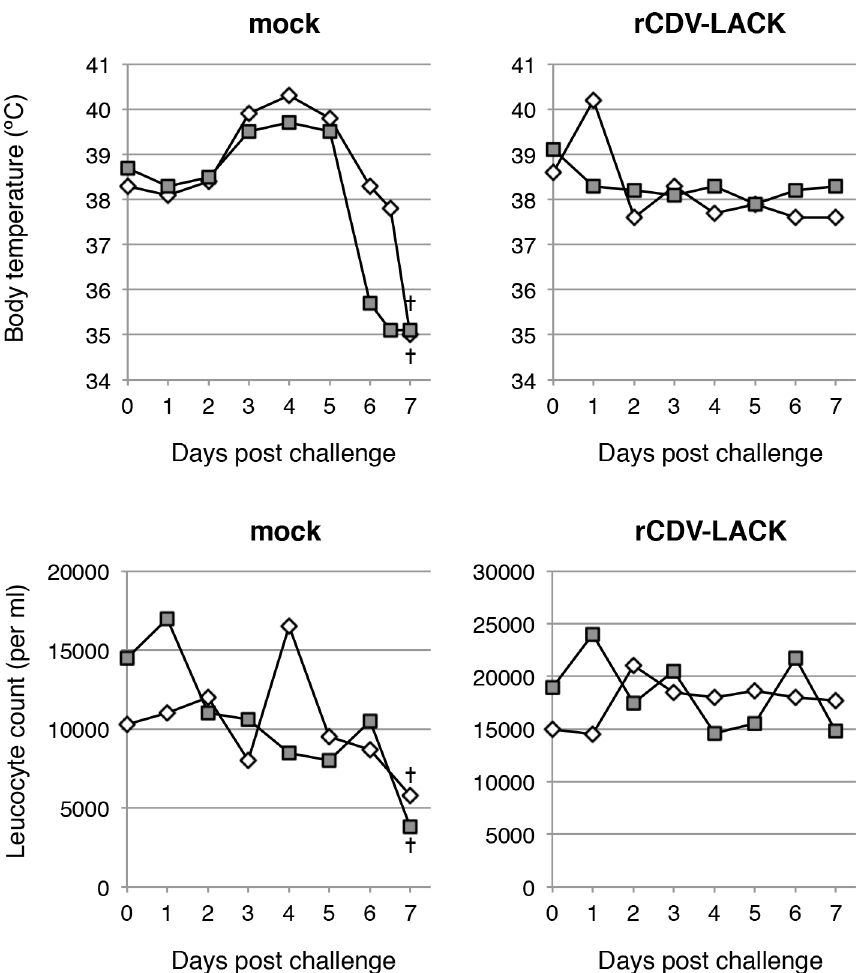
Fig 2. Changes in body temperatures and leukocyte counts after virulent CDV challenge. The body temperatures and leucocyte counts of mock- and rCDV-LACK-immunized dogs after challenge with the virulent Snyder Hill strain of CDV were measured daily. At 7 days after challenge, the mock-treated dogs were in a moribund state and were euthanized ( † ). Each symbol represents one animal.